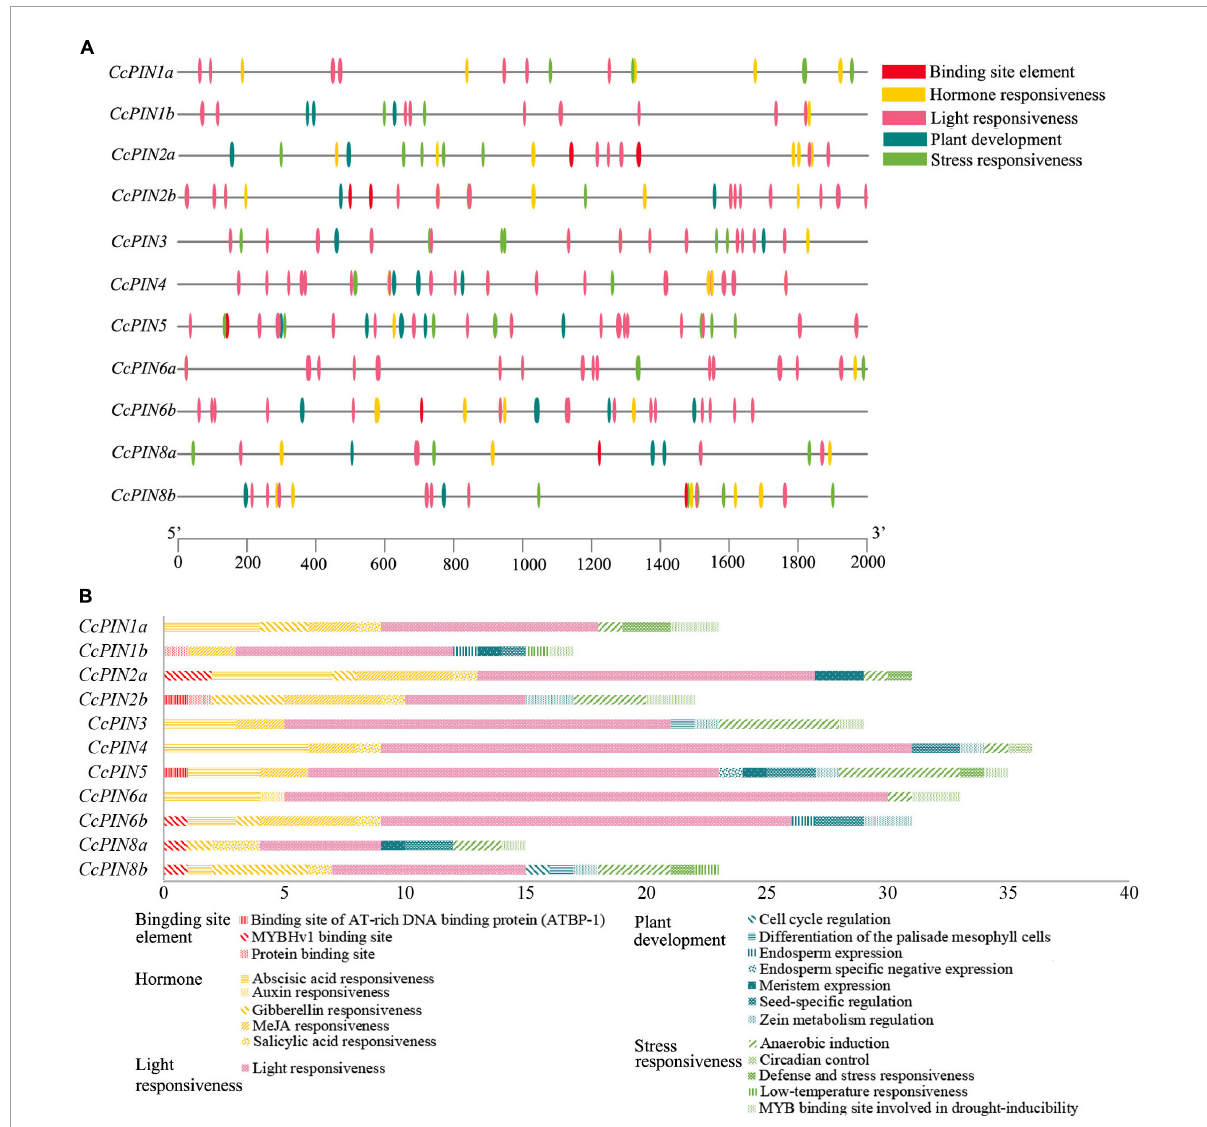
FIGURE6 Cis -acting elements on the promoters of CcPIN family genes. (A) The distribution of cis -acting elements. (B) The number of cis -acting elements.